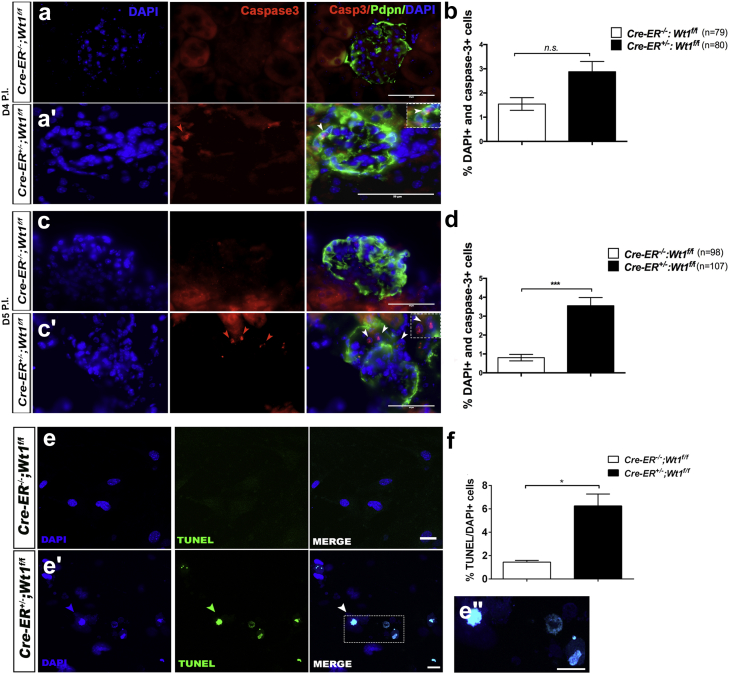
Podocyte apoptosis in CAGG-CreERTM−/+;Wt1f/ftransgenic mice following tamoxifen administration (a,a′). Shown are split-channel and merged micrographs of glomeruli following double immunofluorescence labeling of transgenic mouse kidney tissue sections with anti-Cleaved-Caspase-3 (Casp-3) (Alexa Fluor 594–conjugated secondary antibody) and anti-Podoplanin (Alexa Fluor 488–conjugated secondary antibody) at day (D) 4 postinduction (PI). Images were counterstained with 4′,6-diamidino-2-phenylindole (DAPI). At D4 PI, Cleaved-Caspase-3–positive, Podoplanin-positive cells were observed in DAPI-positive cells in mutant glomeruli (a′) and not in control glomeruli (a′). Bars = 25 μm. (b) Quantitative graphs showing mean percentage of DAPI-positive, Cleaved-Caspase-3–positive cells per glomerulus at D4 PI in control and mutant mice. Bars represent mean and error bars indicate the SEM. A nonsignificant increase was observed in the number of DAPI-positive, Cleaved-Caspase-3–positive glomerular cells in control versus mutant mice at D4 PI: controls versus mutants (n = 79 vs. n = 80 glomeruli from n = 3 per genotype); 1.6 ± 0.3% versus 3.0 ± 0.4%, P = 0.06, not significant (NS). Student t-test. (c,c′) At D5 PI, Cleaved-Caspase-3–positive (red arrows), DAPI-positive cells in mutant glomeruli stained with Podoplanin (inset, white arrows) and not in control glomeruli. (d) Quantitative graphs showing mean percentage of DAPI-positive, Cleaved-Caspase-3–positive, Podoplanin-positive cells per glomerulus at D5 PI in control and mutant mice: controls versus mutants (n = 98 vs. n = 107 glomeruli from n = 3 per genotype); 0.8 ± 0.2% versus 3.6 ± 0.4%, ***P < 0.0001, Student t-test. (e,e′) Representative micrographs following immunofluorescent labeling of terminal deoxynucleotidyltransferase–mediated 2′-deoxyuridine 5′-triphosphate nick end-labeling (TUNEL)–positive primary podocytes (Alexa Fluor 488–conjugated secondary antibody, green arrows) isolated at D6 PI from control and mutant mice. Sections were counterstained with DAPI. (e′′) Higher-power magnification showing a cell nucleus–expressing TUNEL-positive signal. (f) Quantitative graph of apoptotic cells calculating proportion of TUNEL-DAPI–positive podocytes at D6 posttamoxifen in vitro. Bars represent the mean, and error bars represent the SEM. CAGG-CreER−/−;Wt1f/f (n = 2 samples, 10 fields quantified per sample) versus CAGG-CreER+/−;Wt1f/f (n = 2 mice per genotype, 10 fields quantified per primary podocyte line per mouse); 1.4 ± 0.2% versus 6.3 ± 1.0%, *P = 0.04, Student t-test. See also Supplementary Figure S6 for primary podocyte caspase-3/7 staining; Supplementary Figure S7 for TUNEL staining in vivo at D5 PI, and Supplementary Figure S8 for Annexin V PI staining of primary podocytes for control and mutant transgenic mice. To optimize viewing of this image, please see the online version of this article at www.kidney-international.org.